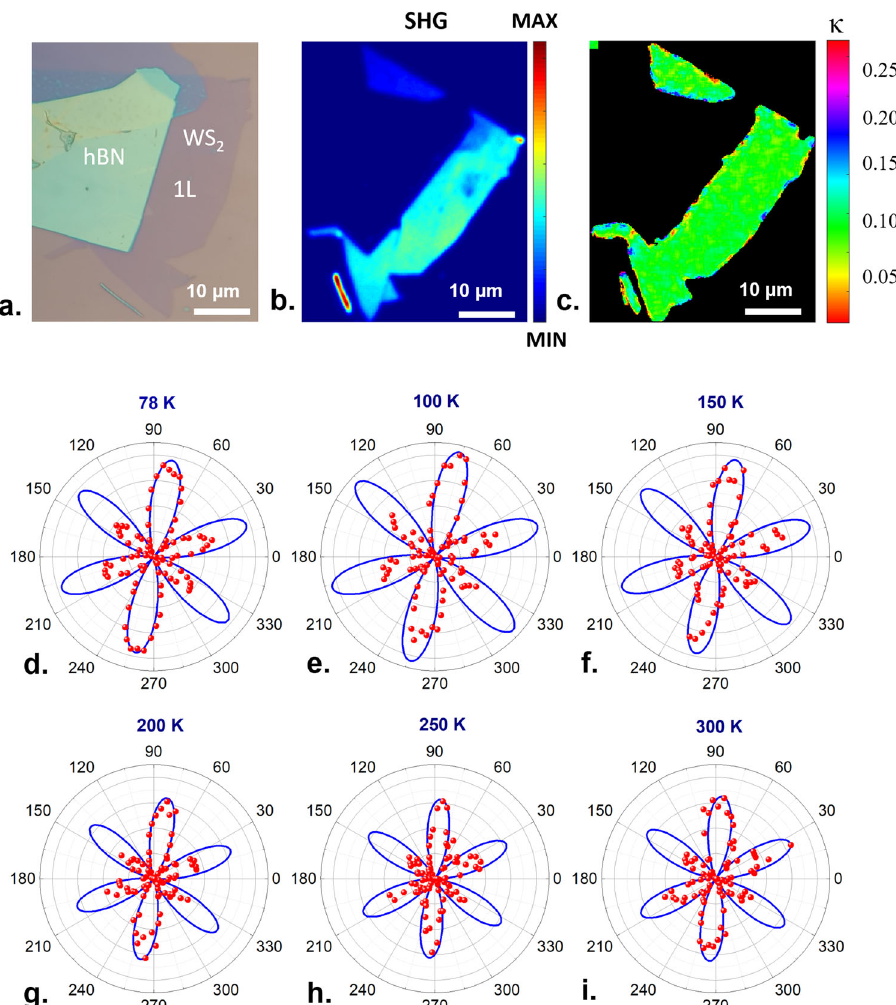
Fig. 3 Temperature-dependent imaging of valley population imbalance in monolayer WS 2 . a Optical image of the WS 2 sample. b SHG intensity mapping of monolayer WS 2 at 78 K. c Imaging of VPI in terms of parameter κ , at 78 K. d – i PSHG intensity polar diagrams as a function of the incident fi eld polarization angle, φ , for temperatures 78, 100, 150, 200, 250, and 300 K, respectively. Τ he red spheres correspond to experimental data and the blue line is the fi tting with Eq.